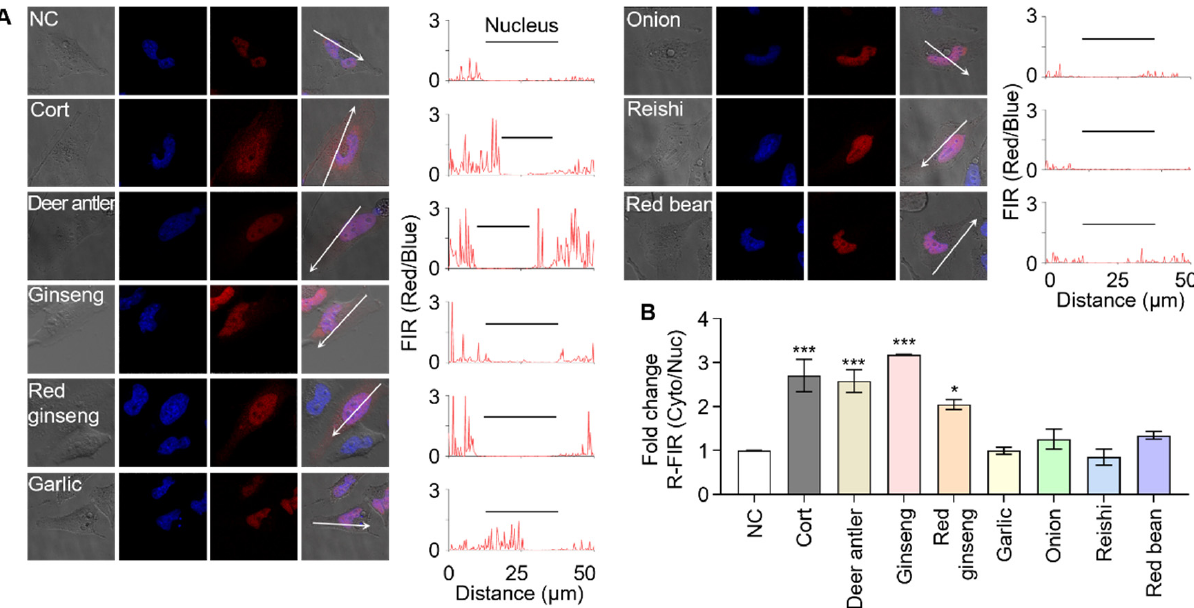
Figure 4. Screening natural product extracts containing cortisol or saponin family compounds. ( A ) The sensor cells were individually challenged with seven different extracts of cortisol or saponin-containing natural products. The sensor cells responded to the cortisol-containing deer antler extract as well as the Rg1- and Re-containing ginseng and red ginseng extracts (scale bar = 20 µ m). ( B ) Fold change in the ratio of red fluorescence intensity from the cytoplasm to that of the nucleus (R-FIR Cyto/Nuc) over untreated control sensor cells is calculated. Data were analyzed by one-way ANOVA using the Tukey multiple comparison test (* p < 0.05, ** p < 0.01, *** p < 0.001).